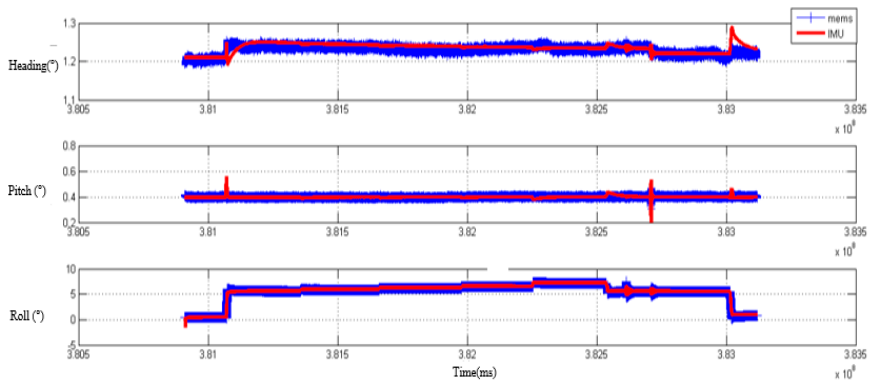
Figure 18. The attitude comparison from transfer alignment of MEMS and fiber IMU. Sensors 2020 , 20 , x FOR PEER REVIEW